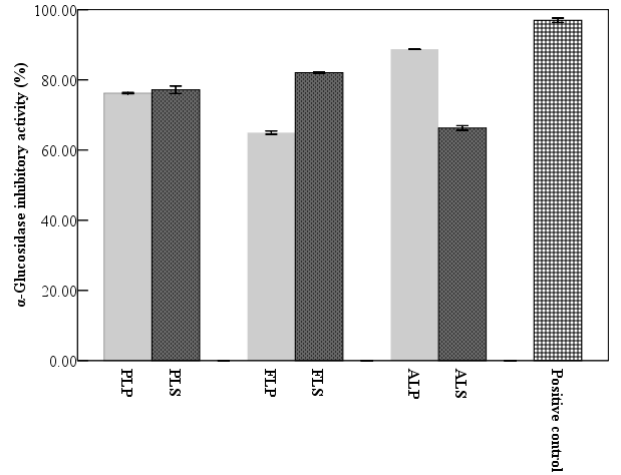
Figure 4. α -Glucosidase inhibitory activities of longan byproducts. PLP: phenolic in longan pericarp, PLS: phenolic in longan seed, FLP: flavonoid in longan pericarp, FLS: flavonoid in longan seed, ALP: alkaloid in longan pericarp, and ALS: alkaloid in longan seed. Each extract was diluted 10 times.